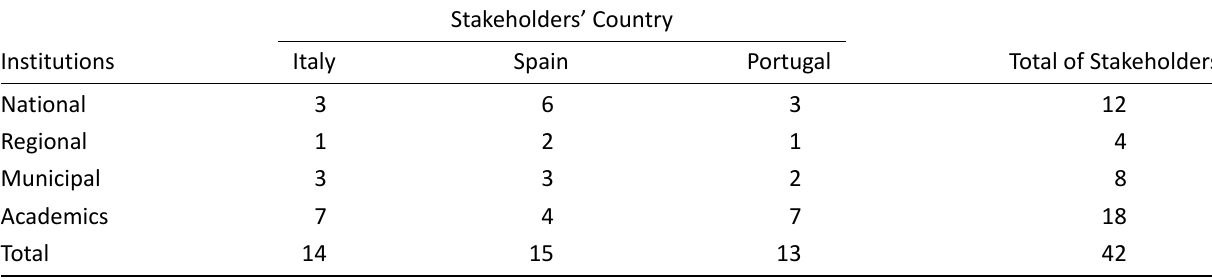
Table 2. Number and distribution of the stakeholders per institution level. Stakeholders’